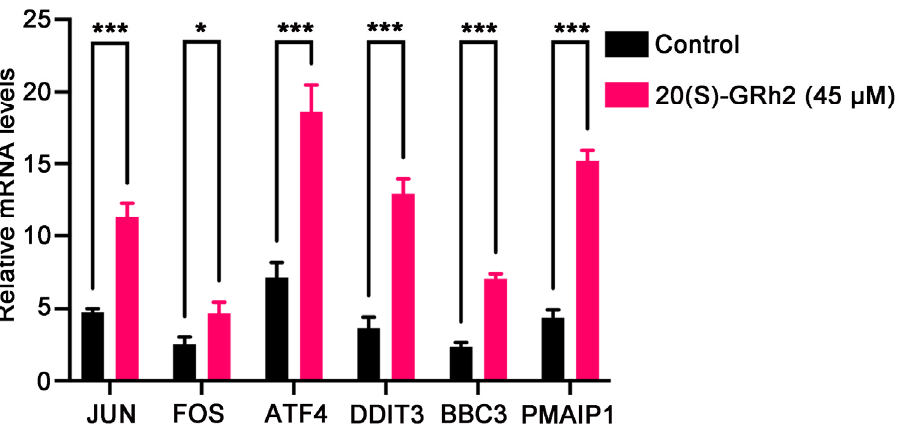
Figure 8. Validation of selected DEGs by qPCR. The mRNA expression levels of the DEGs were quantified in control and 45 µ M 20(S)-GRh2 groups by qPCR. GAPDH mRNA was used as loading control. Data presented as mean ± standard deviation of three independent experiments (two-tailed Student’s t -test). * p < 0.05; *** p < 0.001 vs. control. DEGs, differentially expressed genes; 20(S)-GRh2, 20(S)-ginsenoside Rh2.